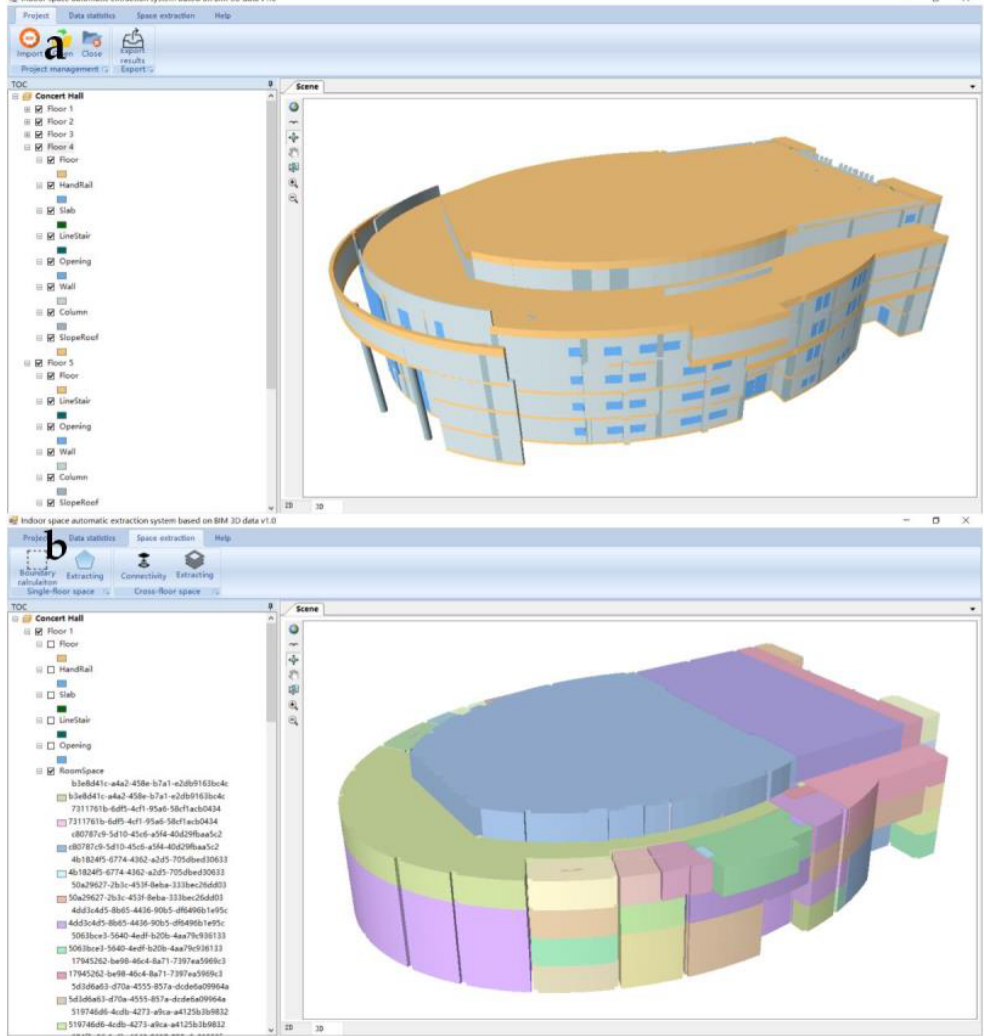
Figure 15. The indoor space automatic extraction system: ( a ) BIM data integrated within GIS software and ( b ) indoor space automatic extraction.